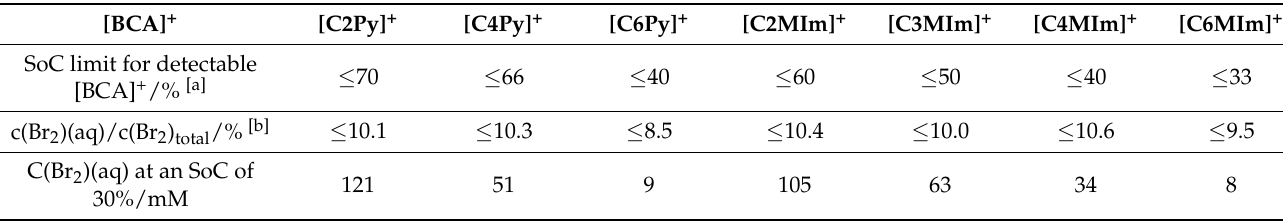
Table 3. Detection limits and detection range for [BCA] + in the aqueous electrolyte phase, maximum fractions of Br 2 in the aqueous phase compared to the global concentration and c(Br 2 )aq for an SoC of